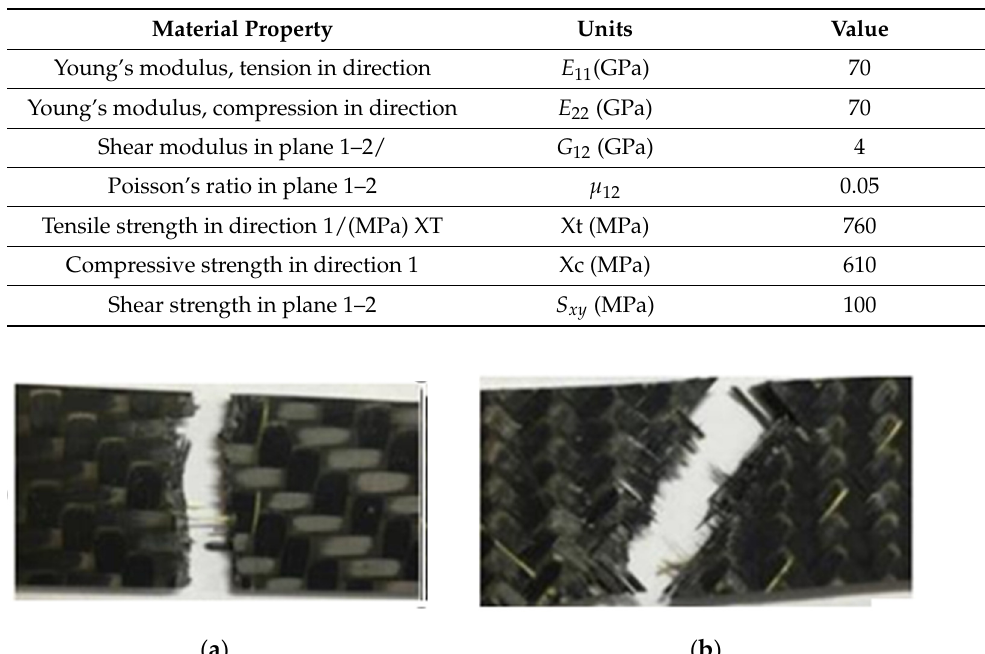
Figure 3. ( a ) stress strain diagram for plies with [0/90 ◦ ] orientation, where 5 samples were used for repeatability purpose, ( b ) stress–strain diagram for plies with [ ± 45 ◦ ] orientation, where 4 samples were used for repeatability purpose. Table 1. Mechanical properties of MTM44-1/CF5804A obtained from tensile test.